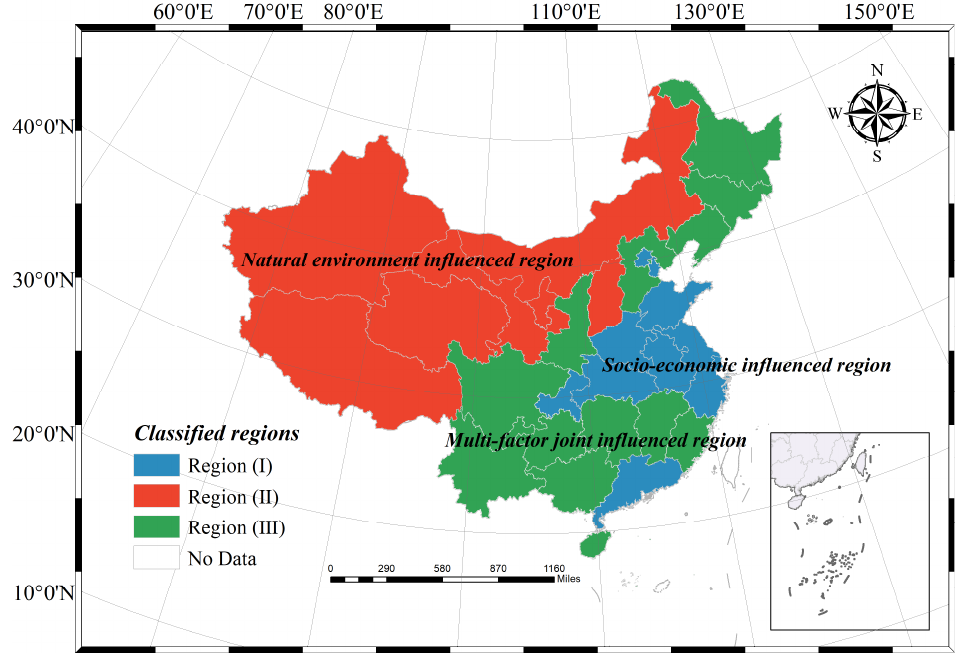
Table 5. Properties of the various influence regions.